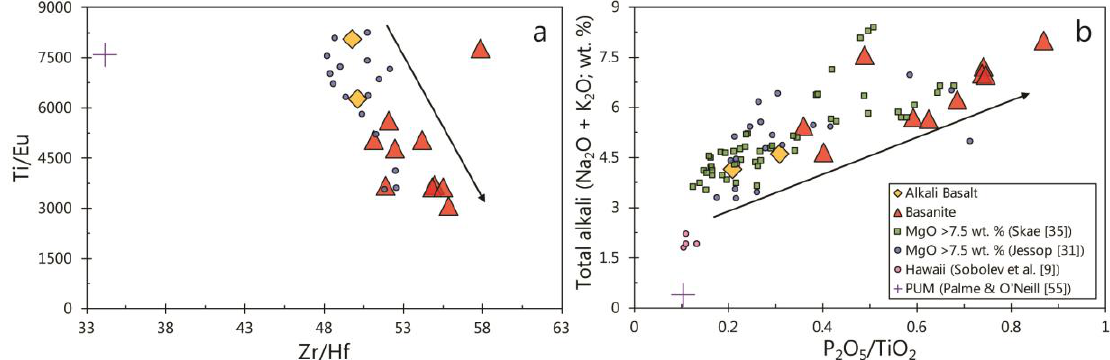
Figure 3. ( a ) Ti / Eu vs. Zr / Hf plots showing a large removal from the primitive upper mantle (PUM), and stronger carbonatite-like signatures in the Buckland basanites compared to the alkali basalts. ( b ) Total alkalis plotted against P 2 O 5 / TiO 2 show a correlation with increasing alkali content. Stronger carbonatite-like signatures were removed from values for PUM and Hawaiian tholeiites, indicating that total alkali content in primitive Buckland rocks may be related to carbonatite metasomatism in the source.